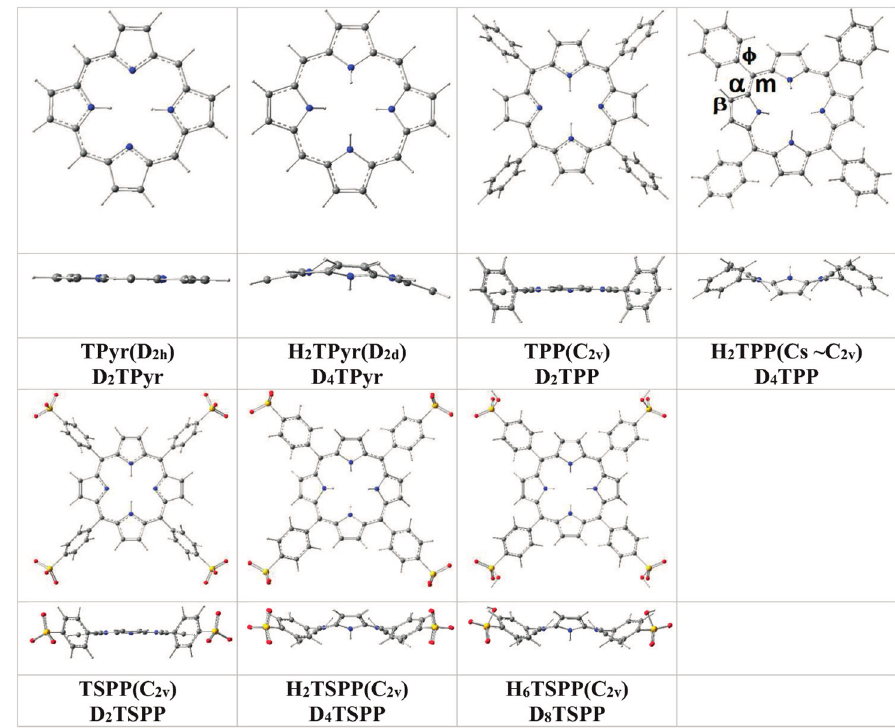
Figure 1. Molecular structures of unsubstituted porphyrin (TPyr), meso -tetraphenylporphyrin (TPP), and anionic meso-tetrakis( p -sulfonatophenyl)porphyrin (TSPP) as well as their protonated structures B3LYP/6-311G(d,p) level of the DFT.